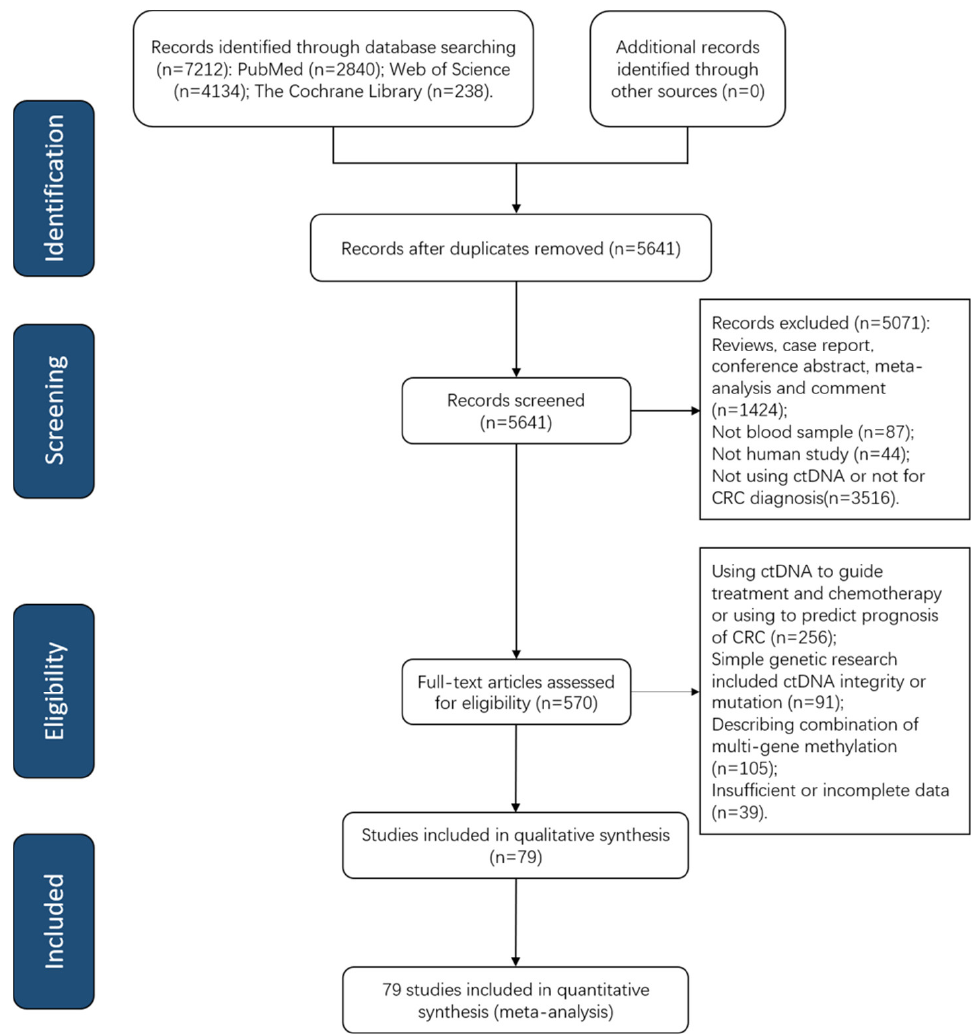
Figure 1. A PRISMA flow diagram of paper search. CRC, colorectal cancer; ctDNA, circulating tumor DNA; PRISMA, Preferred Reporting Items for Systematic Reviews and Meta-Analysis.